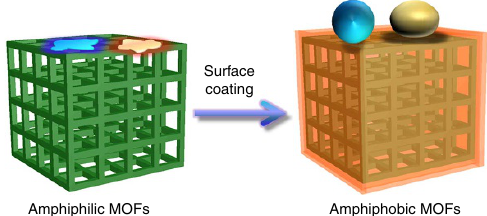
Figure 1 | Amphiphobic surface engineering for MOFs. The resultant MOFs exhibit both superhydrophobicity and oleophobicity, while retaining high crystallinity and intact